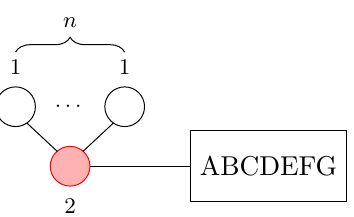
Figure 35 . P ( n ) quiver with SU(2) n (cid:2) G global symmetry, where G is any Lie [1 n ]